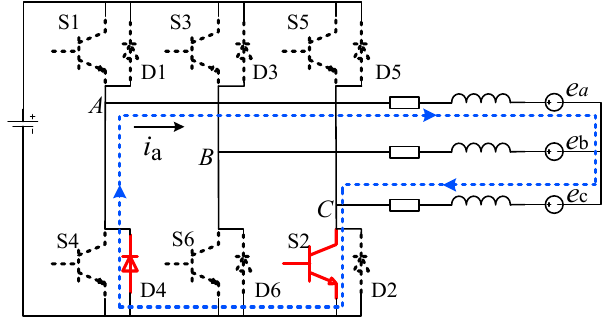
Figure 10. Non-conduction intervals of the A-phase current.